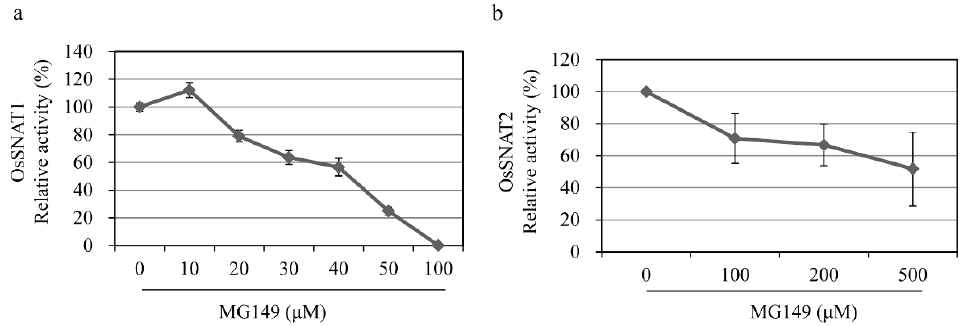
Figure 2. Inhibition of SNAT activity by varying concentrations of inhibitors. Dose-dependent inhibition of rice recombinant ( a ) SNAT1 (OsSNAT1) and ( b ) SNAT2 (OsSNAT2) by different concentrations of MG149. The assays were performed in the assay buffer containing 0.1% ethanol.